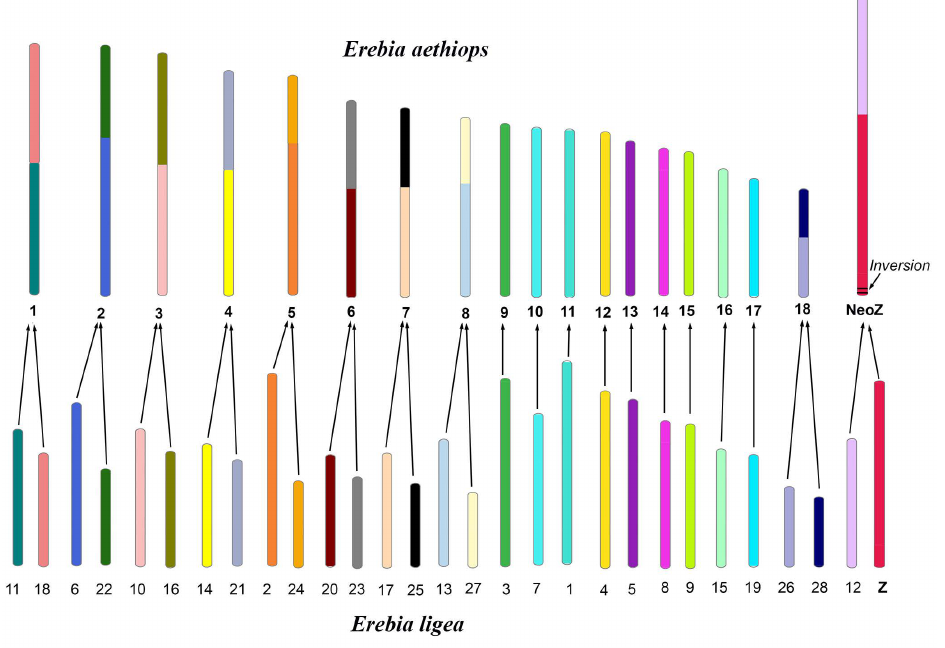
Figure 5. Chromosome comparison between E. ligea and E. aethiops. Karyotypes of E. ligea ( n = 29) (lower row) and E. aethiops ( n = 19) (upper row) are differentiated by 10 chromosomal fusions and a single terminal inversion in the Z chromosome. The serial numbers of chromosomes of each species are taken from GenBank (Supplementary Table S1) and correspond to their